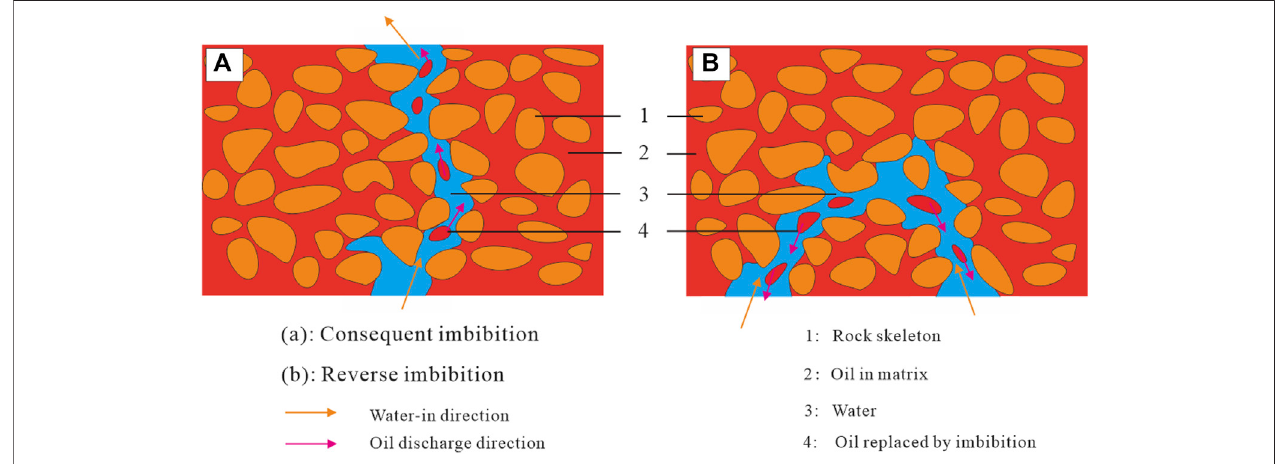
FIGURE 1 | Model diagram of imbibition mechanism. (A) consequence imbibition and (B) reverse imbibition.